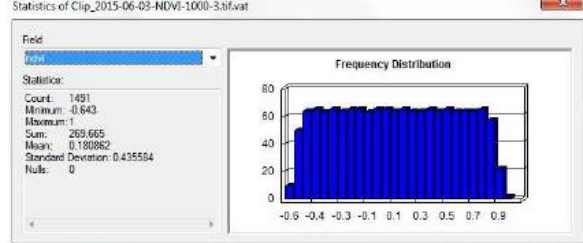
Figure 14. Sector 3 - Distribution frequency 03/06/2015